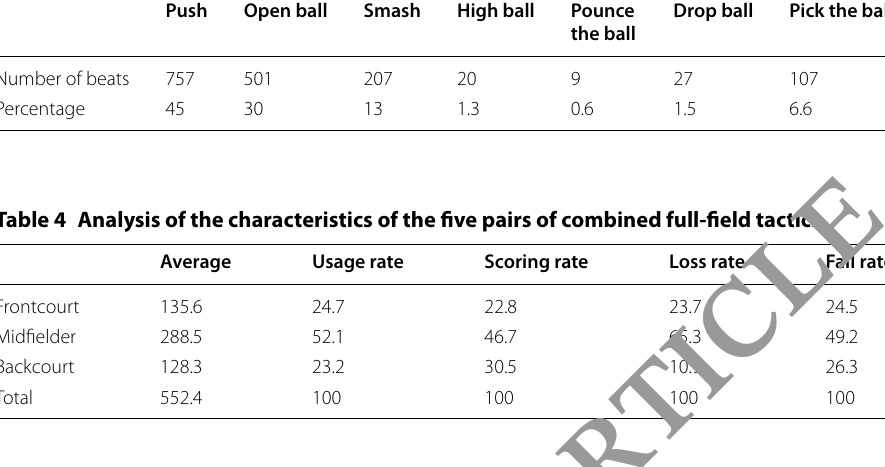
Drop ball Pick the ball the ball